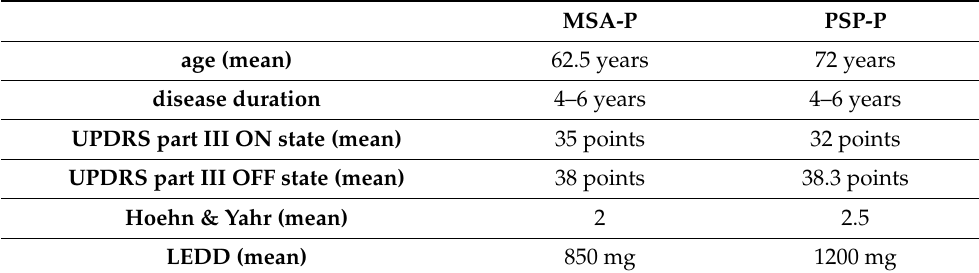
Table 1. Clinical characteristics of the analyzed